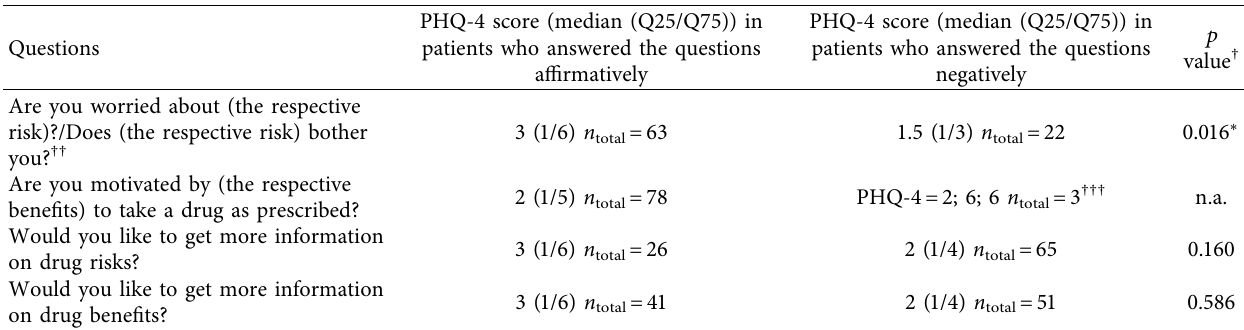
Table 3: Diferences in the PHQ-4-score in patients depending on their answers in the interview.